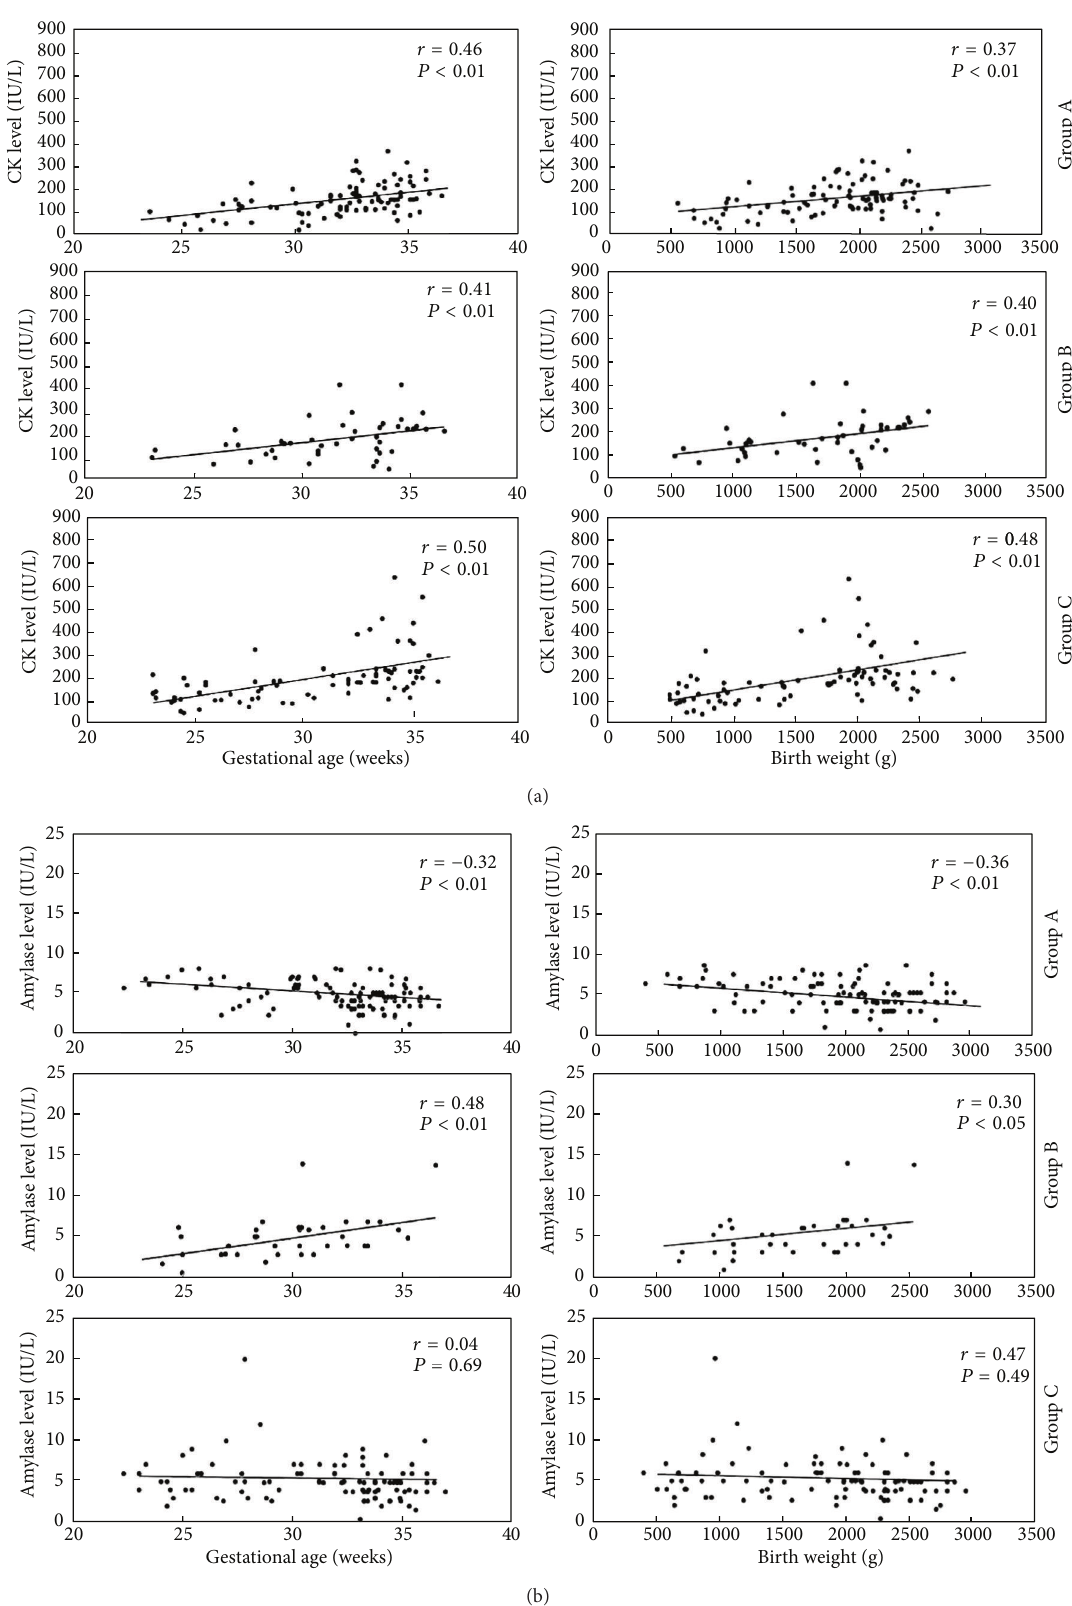
Figure 5: Correlation between CK (a) and amylase (b) levels and gestational age and birth weight in the three groups. (a) Correlation between